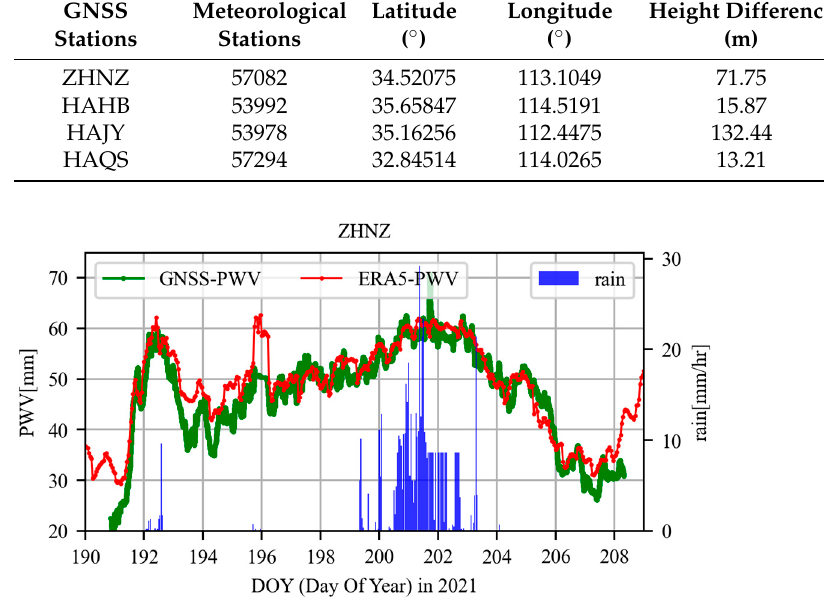
Figure 5. Time series of the GNSS derived PWV (GNSS-PWV) and ERA5 derived PWV (ERA5-PWV) with respect to the hourly rain at the nearby meteorological station.